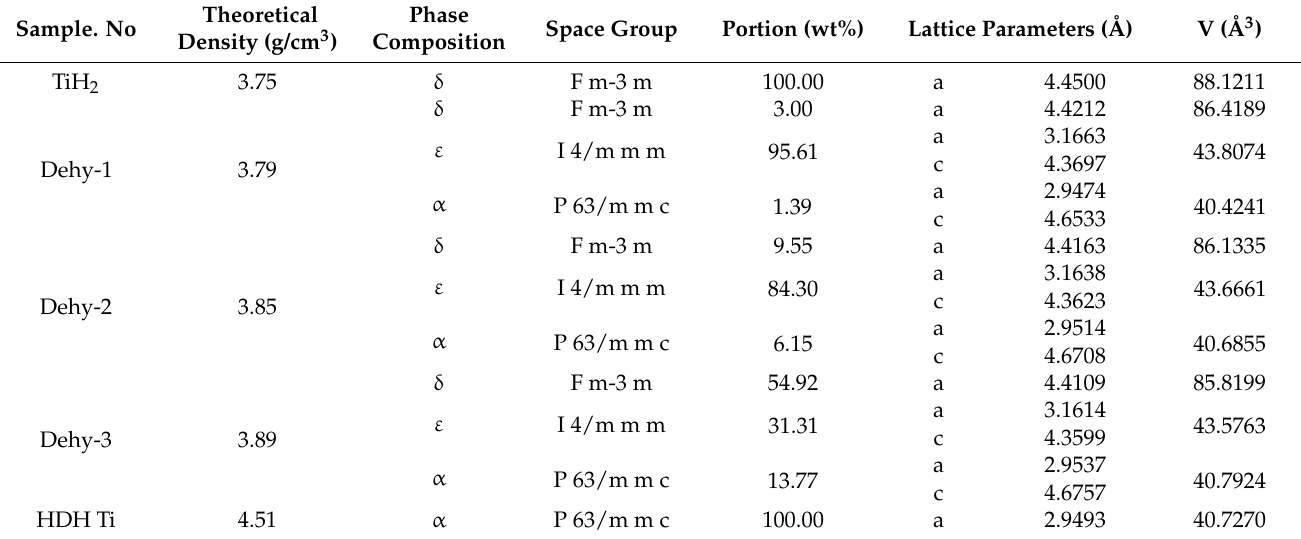
Table 3. Crystallographic data of the TiH 2 , TiH X , and HDH Ti powders based on Rietveld refinement